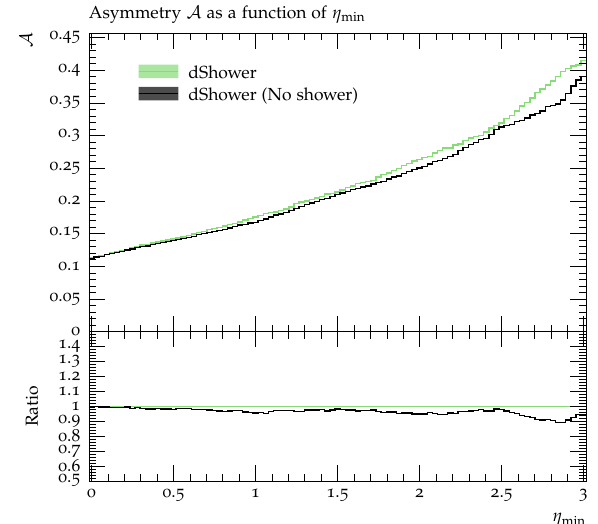
Figure 18 . Asymmetry